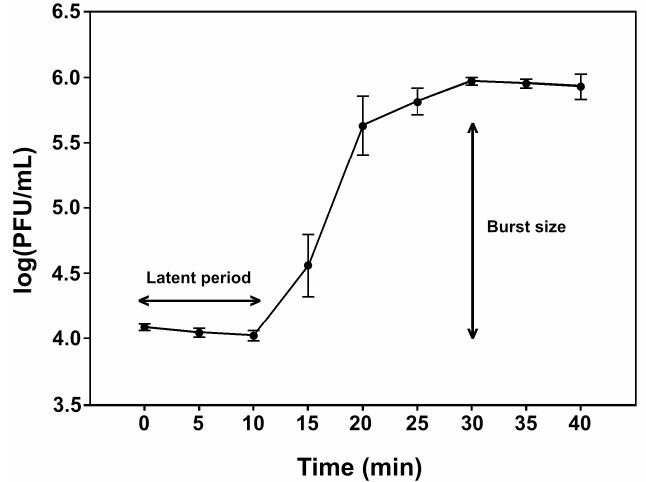
Figure 3. One-step growth curve of the pEp_SNUABM_03 in E. pyrifoliae strain KACC13945. The